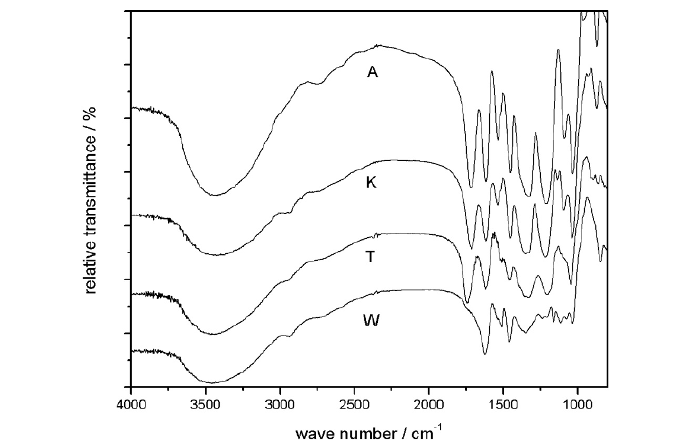
Figure 1. Infrared spectra of vegetable tannins and tannic acid used for the preparation of iron-gall